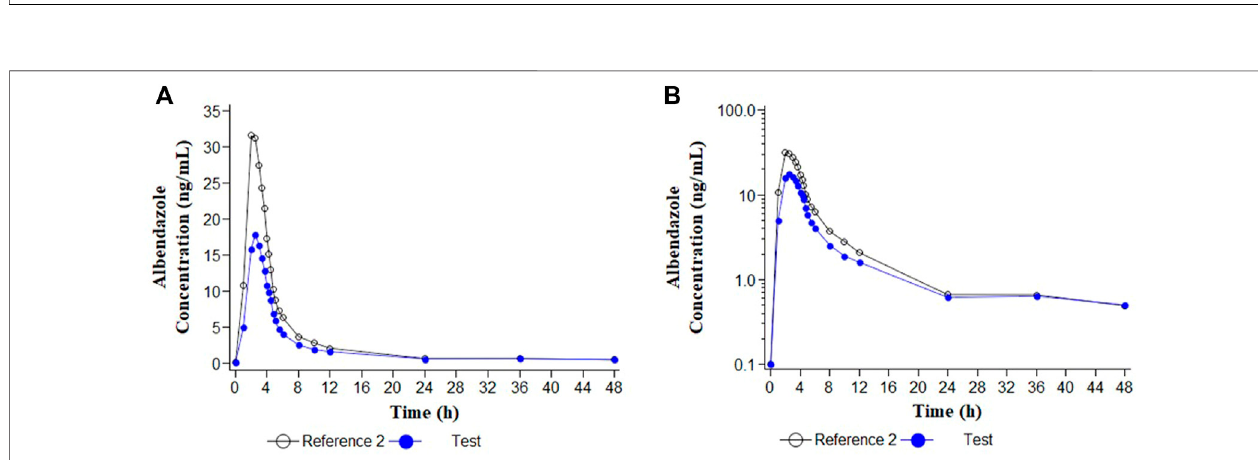
FIGURE 2 | Concentration/time curves for ivermectin H2B1a following the administration of ivermectin/albendazole 18/400 mg tablets (Test) and Ivermectin 6 × 3 mg tablets (Reference 1). (A) Linear scale; (B) Semi-logarithmic scale.